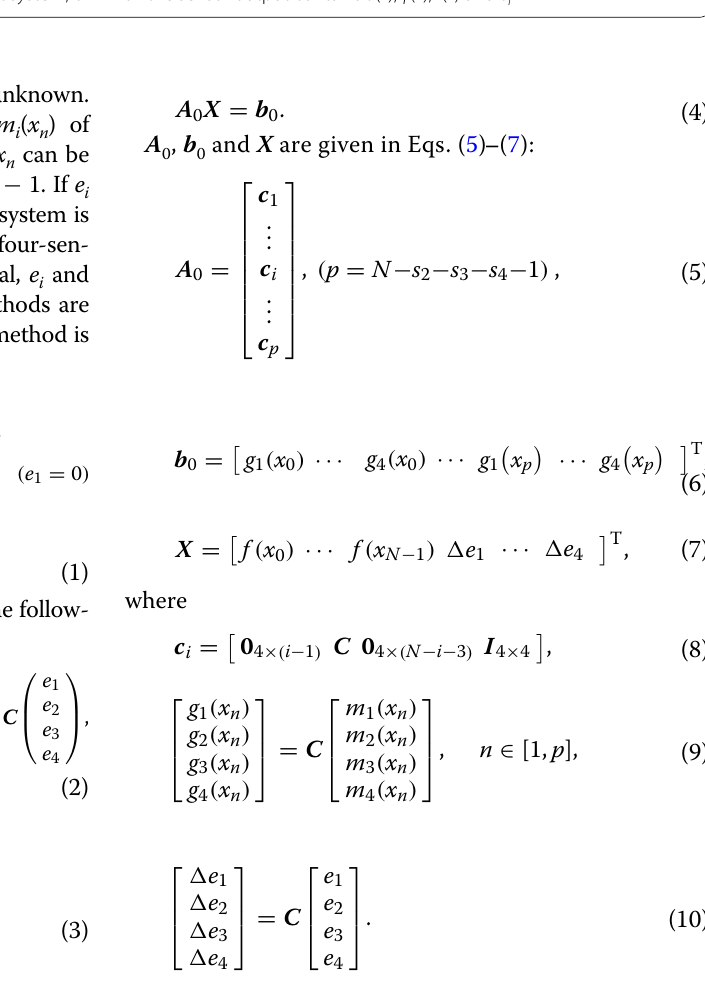
Figure 1 Schematic diagram of the improved measurement system, of which the sensor output contains S ( x ), γ ( x ), f ( x ) and e